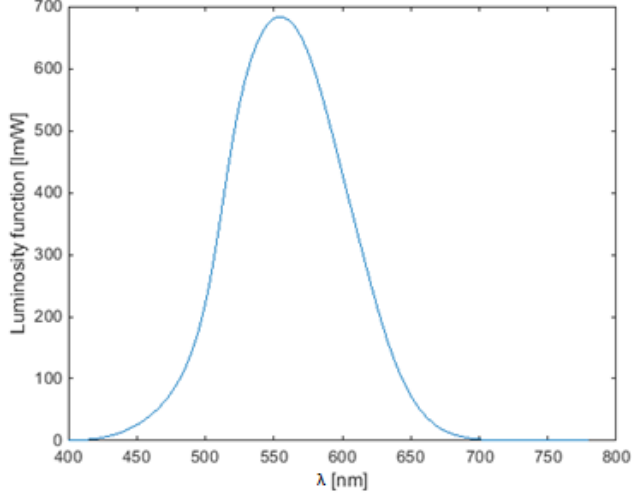
Figure 1. Standard luminosity function for photopic